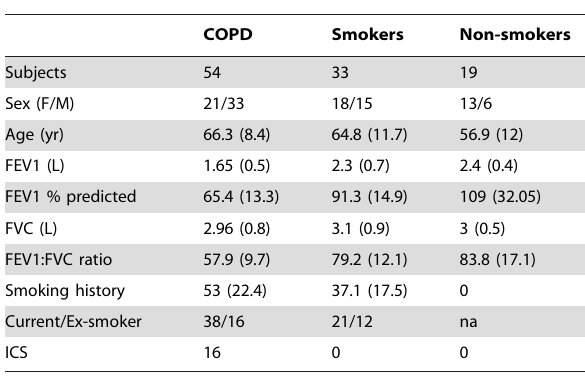
Table 1. Subject Demographics.